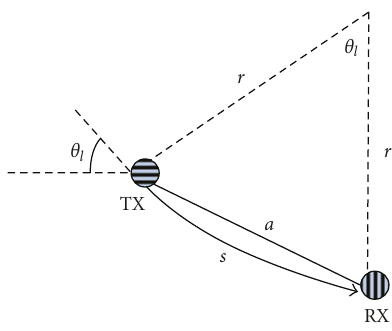
Figure 1: Refracted path modelled as an arc of curvature given the assumption of constant sound velocity gradient.